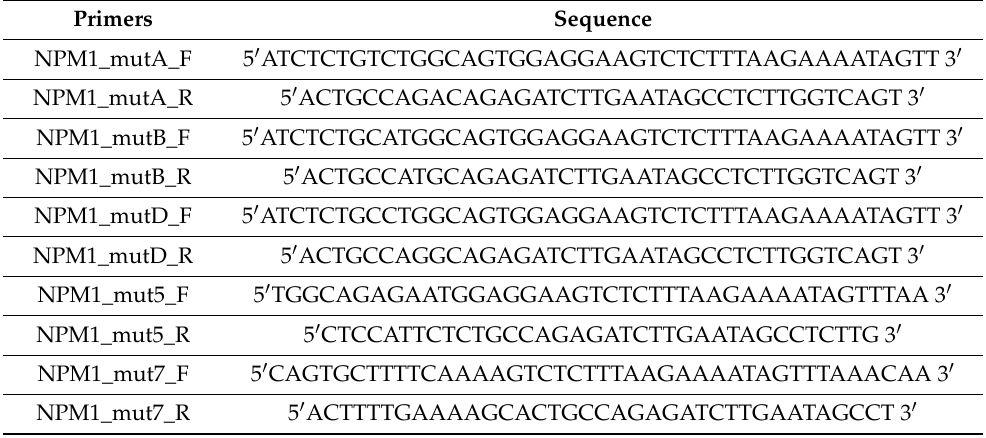
Table 1. Primers